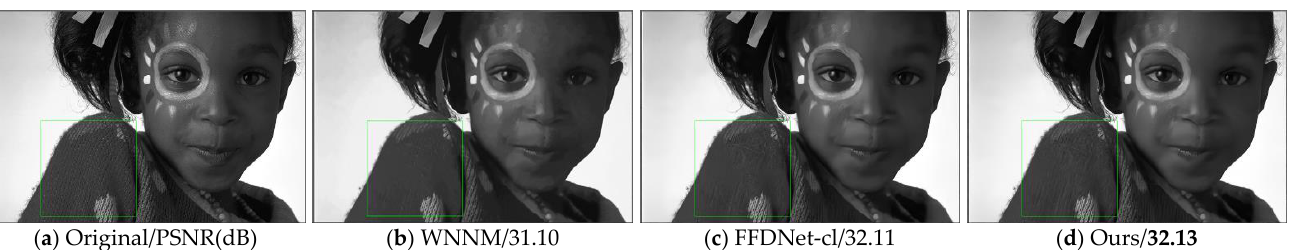
  . ( a ) The original image. ( b ) The result n